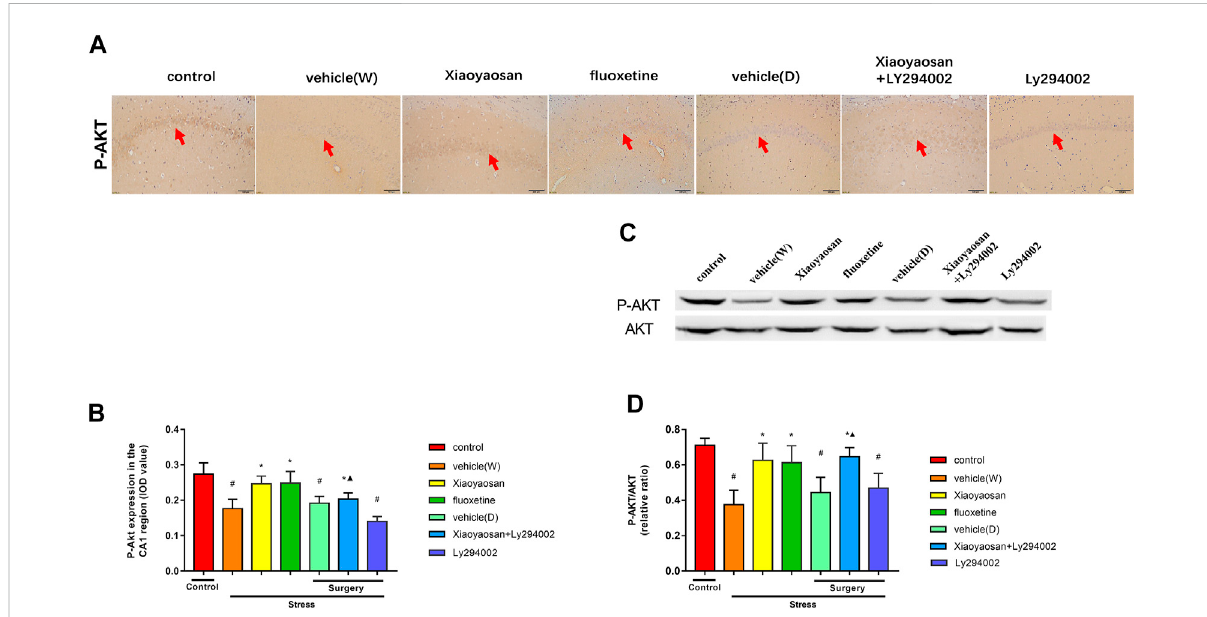
FIGURE 8 Xiaoyaosan elevates the expression of P-AKT/AKT in the hippocampal CA1 region of CUMS rats P-AKT/AKT in the hippocampal CA1 region of CUMS rats (A) Representative micrographs of immunohistochemical staining (sections were counterstained with hematoxylin; original magni fifi cation, ×200) and (B) quantitative analysis showing the expression of P-AKT in the hippocampal CA1 region (C) . Representative images and western blot analysis (D) of western blot assay showing the relative expression ratio of P-AKT/AKT in the hippocampal CA1 region. All data are expressed as the mean ± SD. # p < 0.05 compared to the control group; * p < 0.05, compared to the vehicle (W) group; ▲ p < 0.05 compared to the Ly294002 group, n =